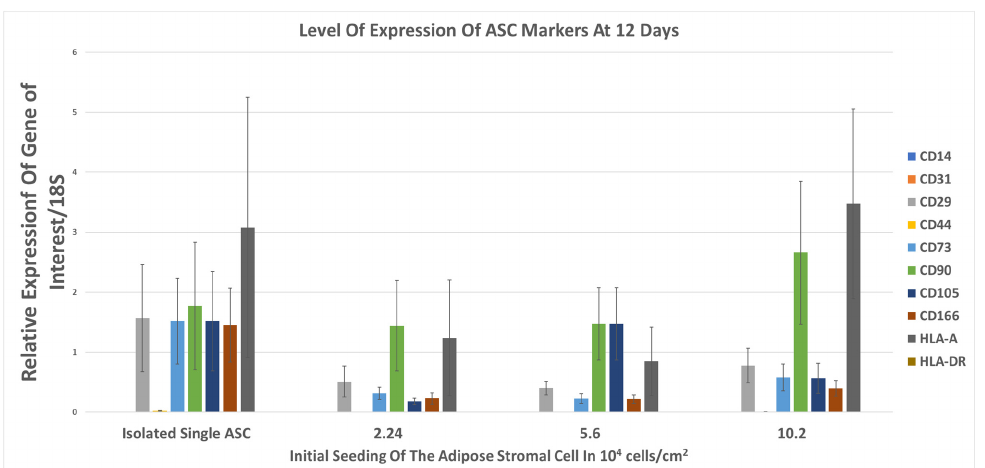
Figure 5. Relative level of expression of ASC markers, in the cell sheets compared to the isolated ASC, at 12 days (n = 3, mean ± SD).